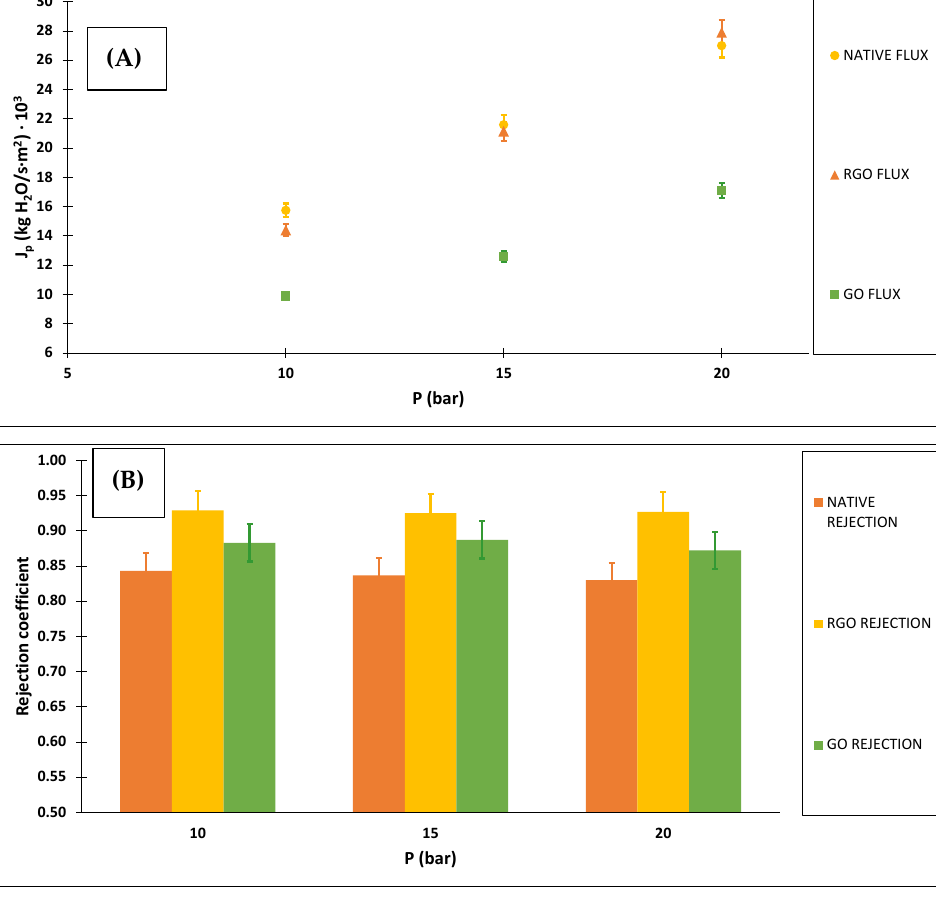
Figure 6. Permeate mass flows ( A ) and rejection coefficients ( B ) using 10 ppm ibuprofen solutions against different operating pressures.